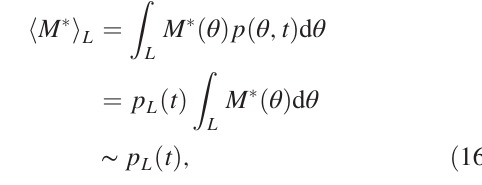
FIG. 5. (a) Time evolution of the total lengths of GBs, SAGBs, and LAGBs, namely, Λ (b) Time evolution of the length scale R t 1 = 3 (black dashed line) at long times. The bond-orientational correlation length, R 6 , exhibits the same scaling properties as R offsets of the curves are arbitrary to facilitate visualization and the differences in time range are attributable to difficulties in accessing R 6 ( R and Λ ) accurately at long (short) L I